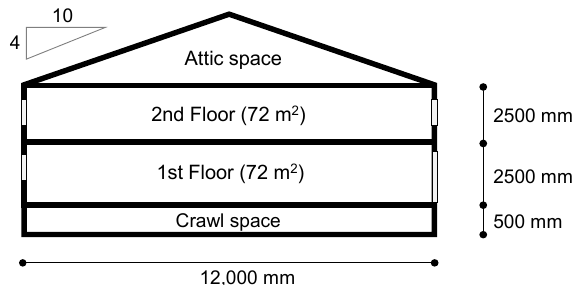
Figure 6. Analyzed Kyo-machiya model.